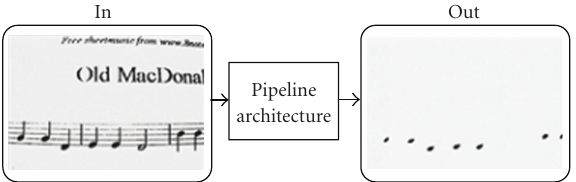
Figure 12: Example of head extraction in real